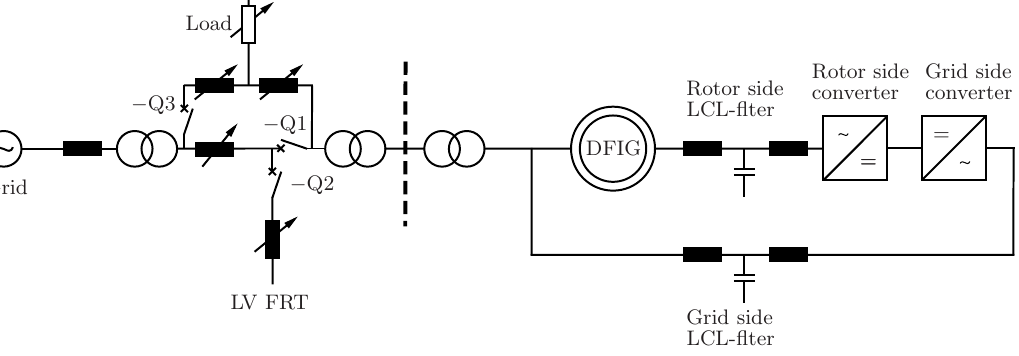
Figure 8. Single line diagram of the test bench.